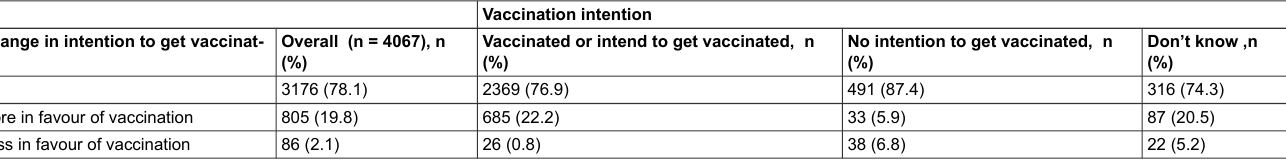
Table 2: Change in intention to get vaccinated against COVID-19 in the past 3 months.